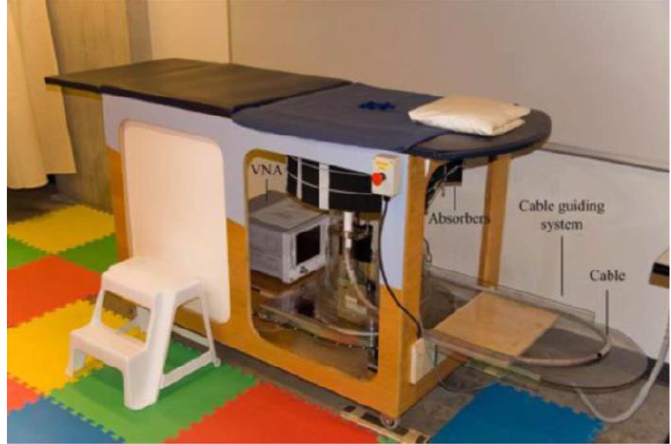
Figure 18. Tissue sensing adaptive radar (TSAR) prototype radar-based MI system for breast cancer detection developed by Fear et al. [78]. Reprinted with permission from [78].